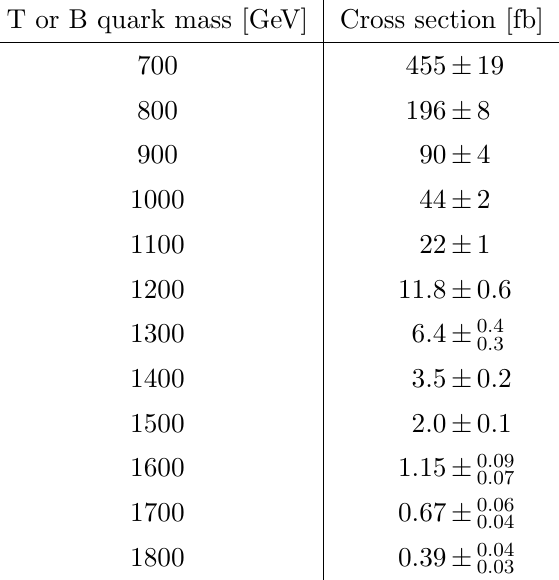
Table 1 . Predicted cross sections for pair production of T or B quarks for various masses. Uncer- tainties include contributions from energy scale variations and from the